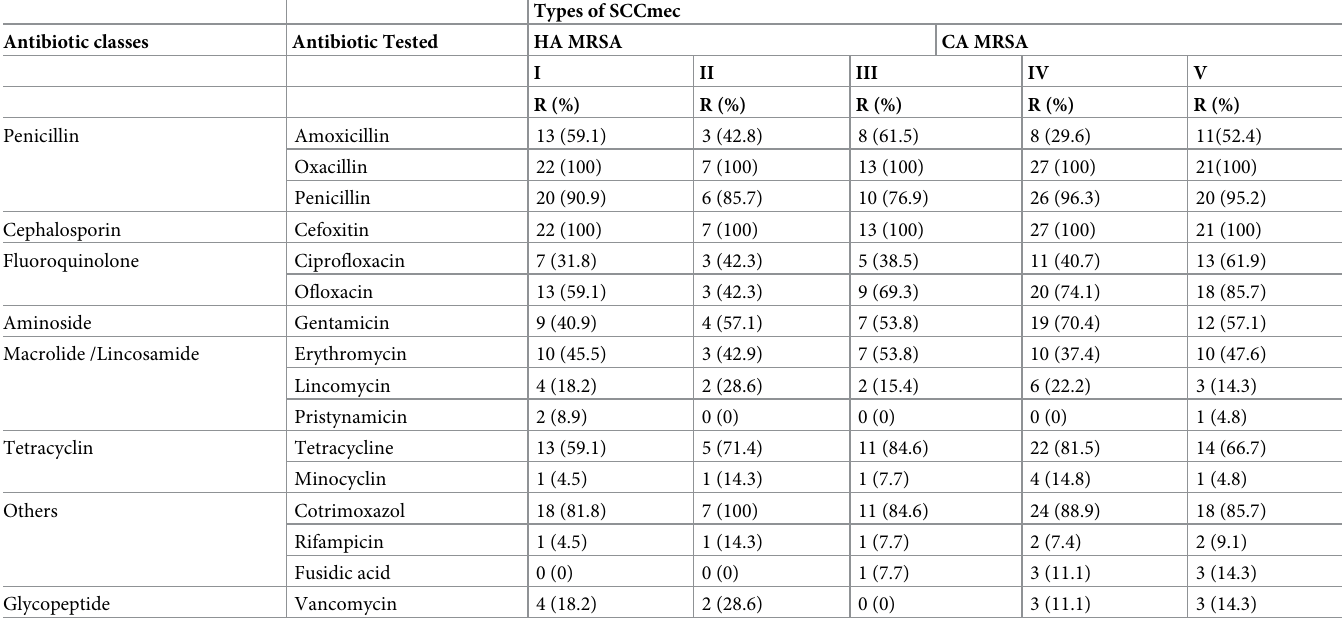
Table 7. Distribution of SCCmec types according to antibiotic resistance phenotypes for MRSA.